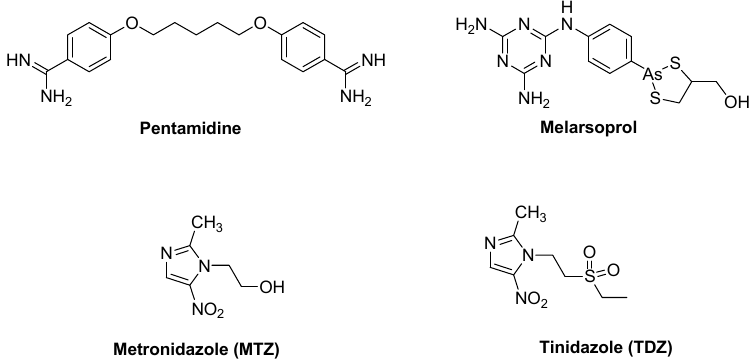
Figure 1. Chemical structures of drugs for treatment of sleeping sickness and trichomoniasis.